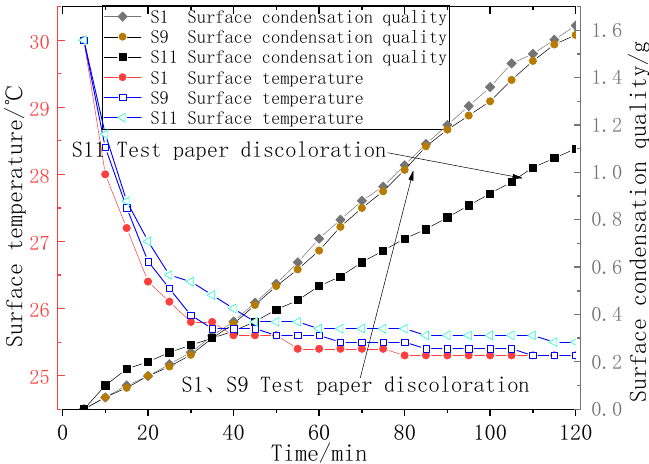
Figure 17. S1, S9, and S11 condensation process diagram under working condition T11.